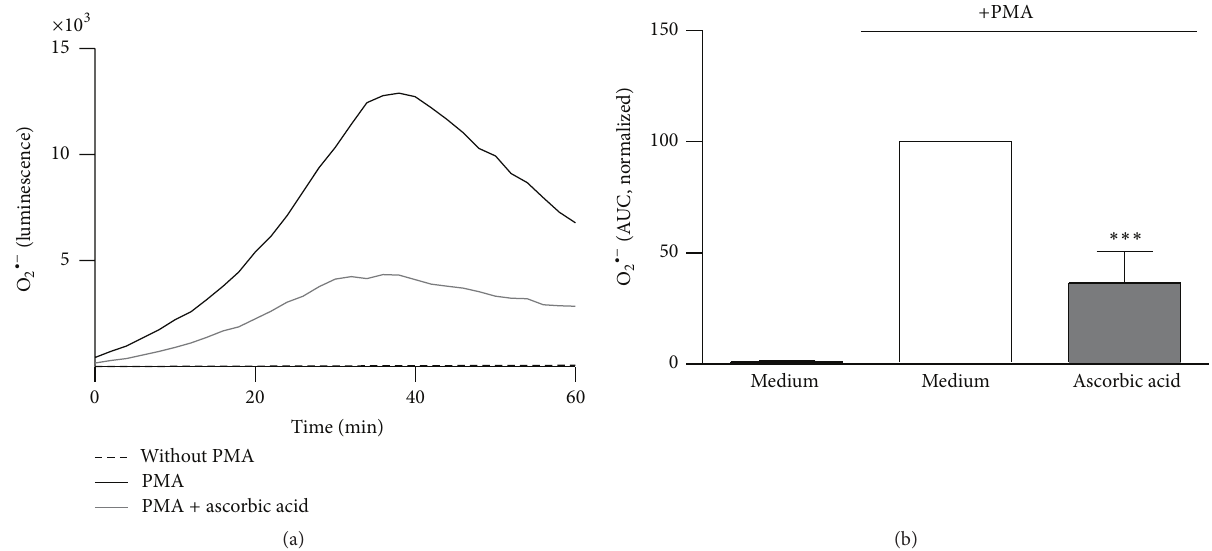
Figure 1: Analysis of the ROS production in neutrophils by calculation of the area under the curve. The extracellular ROS formation of neutrophils incubated with 2 mM ascorbic acid decreases as measured by the lucigenin amplified chemiluminescence assay. Neutrophils were coincubated with or without ascorbic acid for 30min at 37 ∘ C and the ROS release was induced by PMA. The area under the curve (AUC) of the time kinetics (1h) of superoxide (O 2∙− ) release of each curve (a) was calculated and represented as bar graph. Data show mean ± SD from 3 independent experiments of 3 different donors; ∗∗∗ 𝑃 < 0.001 (b). The figure is representative for the analysis of all experiments detecting the ROS and NET